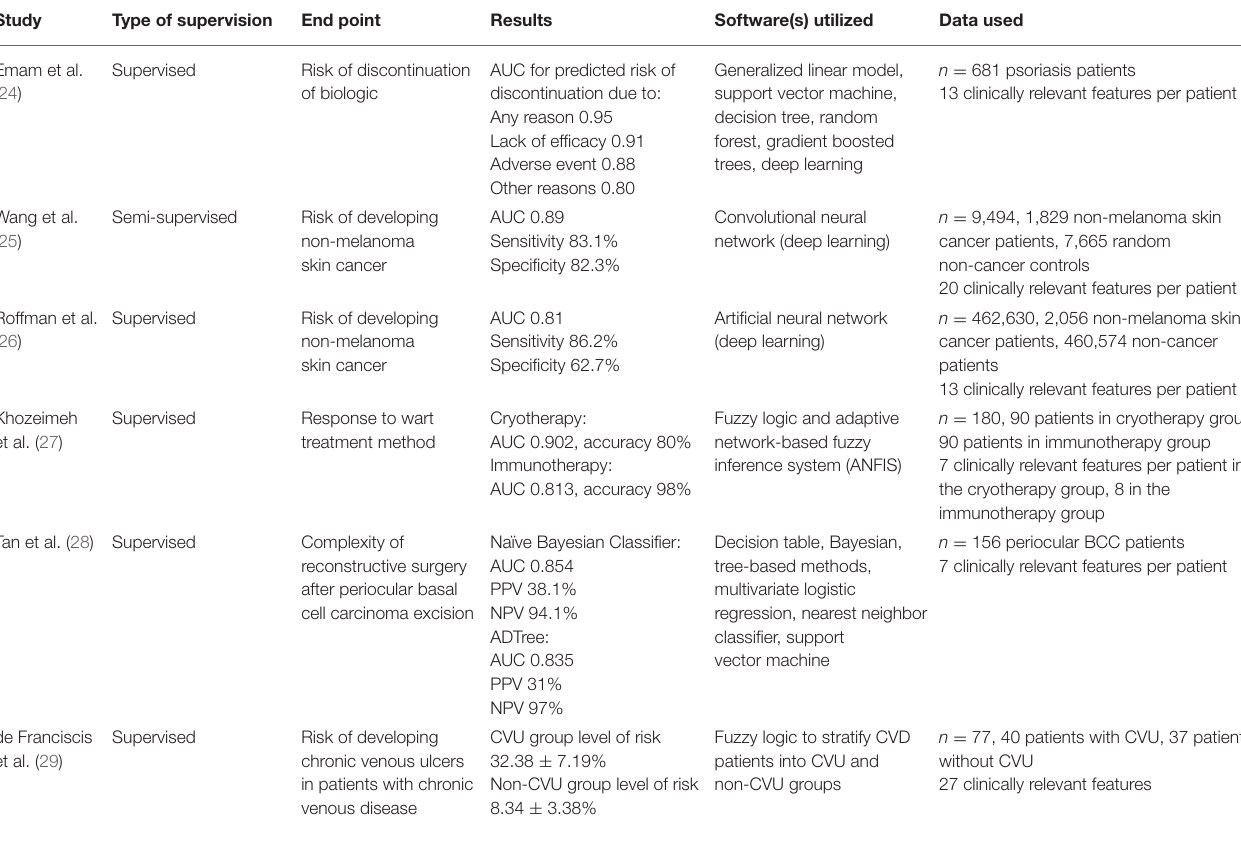
TABLE 1 | Summary of literature on the use of machine learning in predicting dermatological